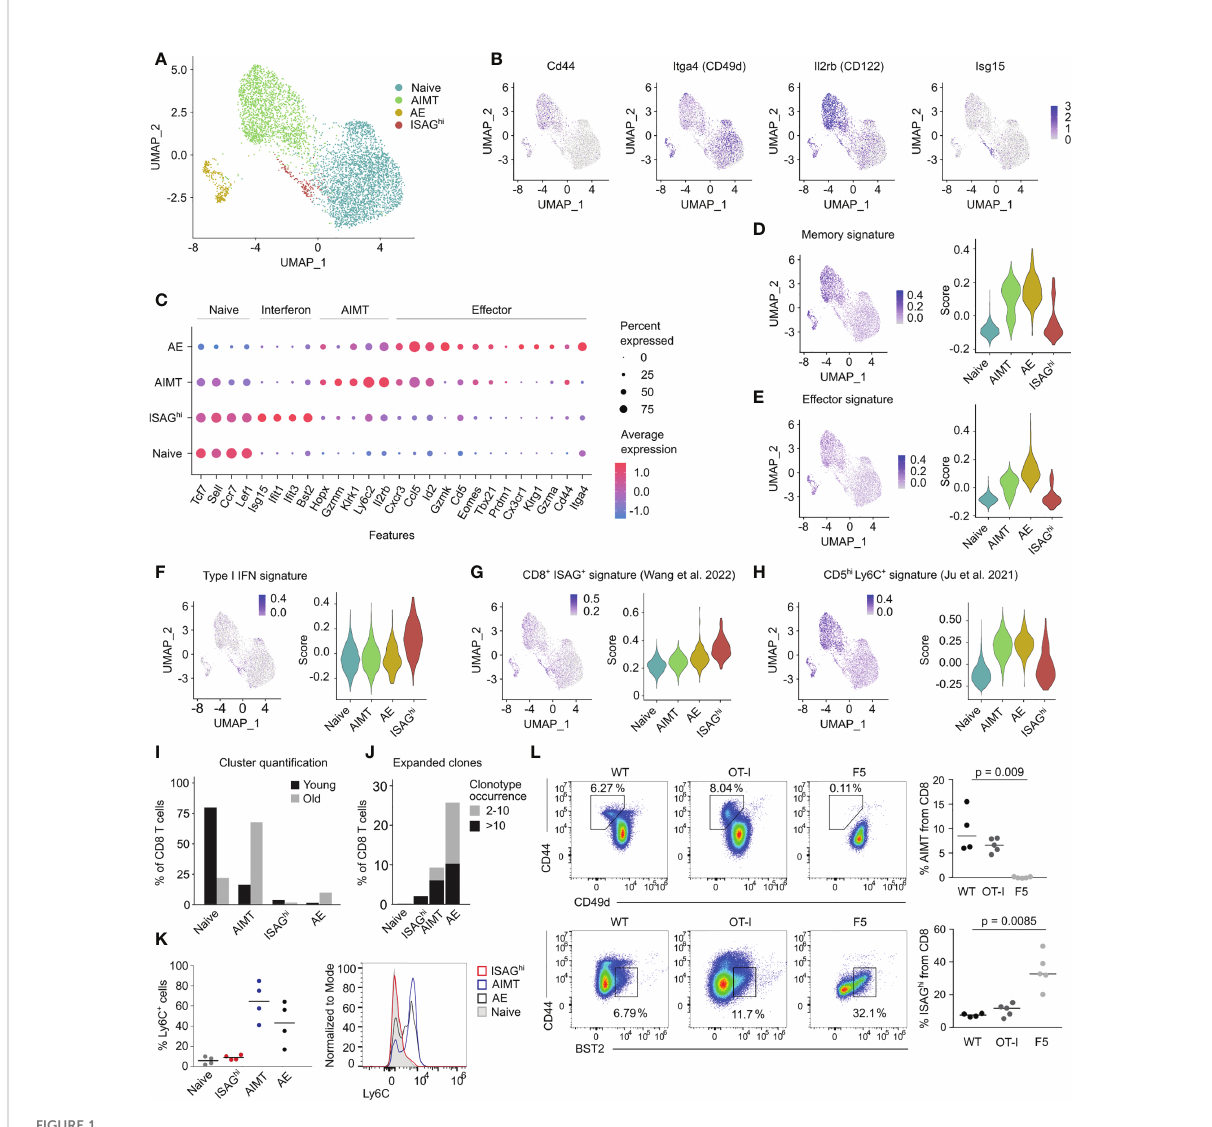
FIGURE 1 Transcriptomic analysis of murine CD8 + T cells. (A) UMAP projection of FACS-sorted CD8 + T cells from peripheral blood of three young and three aged C57BL/6J mice processed by scRNAseq. The cells from mice with the corresponding age were fi rst pooled and labeled with barcoded antibodies. Subsequently, cells from young and aged mice were pooled prior to the scRNAseq. Cells are colored by manual annotations. (B) UMAP projections showing the expression of selected genes. (C) Expression of the signature genes of naïve, ISAG hi , AIMT and effector cells. Color of the dot indicates the average expression, size indicates the percentage of cells with non-zero expression. (D – H) Signature scores showing the expression of different gene modules in naïve, AIMT, AE, and ISAG hi cells. (D) Expression of the module of immune memory genes expressed uniquely in CD8 + memory T lymphocytes (compared with effector or naïve cells), MSigDB # M10845 (19). (E) Expression of the module of genes down-regulated in naïve CD8 + T cells versus effector CD8 + T cells, MSigDB # M3036 (20). (F) Expression of genes from the GO pathway GO:0060338 “ regulation of type I interferon-mediated signaling pathway ” . (G) Expression of markers of human ISAG + CD8 + T cells from the pan-cancer single cell T-cell atlas (21). (H) Expression of genes upregulated in murine CD5 hi Ly6C + cells compared to CD5 low cells (16). (I) Comparison of the percentage of cells in each scRNAseq cluster in young versus aged mice. (J) Percentage of clonally expanded cells in each scRNAseq cluster. The count indicates the number of cells with the same TCR a CDR3 and TCR b CDR3 nucleotide sequence. Cells with TCR receptors occurring only once in the dataset are not depicted. (K, L) Flow cytometry analysis of ISAG hi and AIMT cells. (K) Quanti fi cation (left) and a representative histogram (right) of a fl ow cytometry analysis of Ly6C on naïve, ISAG hi , AIMT, and AE cells. n = 4 in two independent experiments. (L) Percentage of AIMT cells (top) and ISAG hi cells (bottom) in WT mice and in transgenic mice with monoclonal OT-I and F5 TCRs. See the FMO control in Figure S1M. OT-I: n = 5, F5: n = 5, WT: n = 4. Three independent experiments. Medians are shown. P-value was calculated using the Kruskal-Wallis